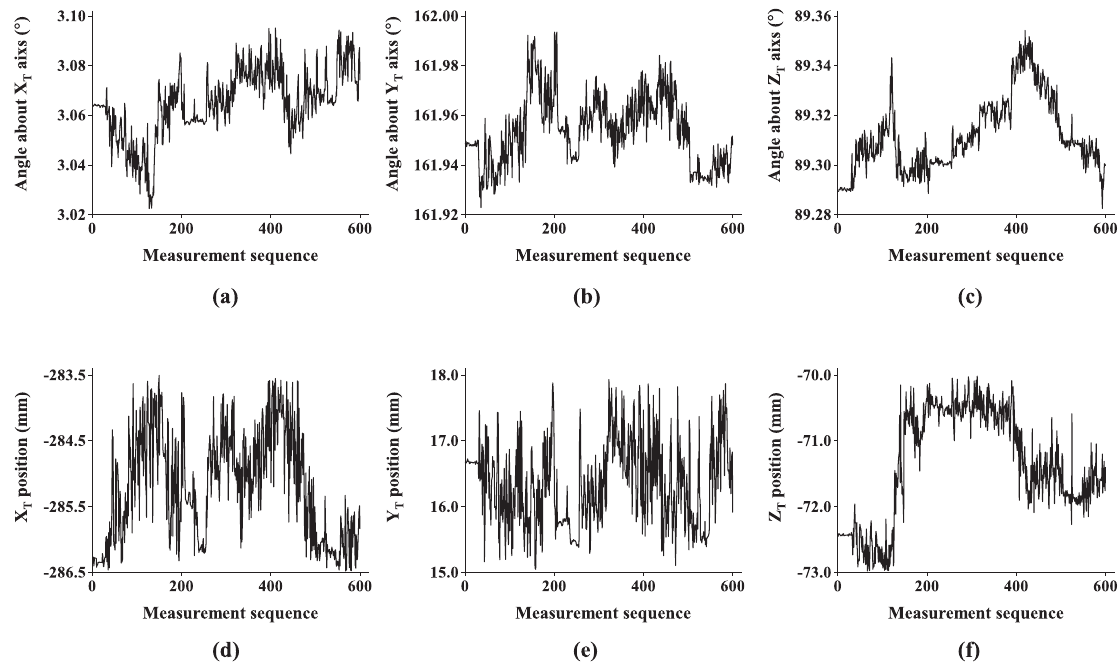
Figure 19. Six degrees of freedom of the helmet in the T-Mac coordinate system: ( a ) angle about X T axis, ( b ) angle about Y T axis, ( c ) angle about Z T axis, ( d ) position along X T axis, ( e ) position along Y T axis and ( f ) position along Z T axis. Table 3. Numbers of mismatching with and without motion prediction Feature Correspondence Feature Correspondence Angular Velocity Without Motion Prediction